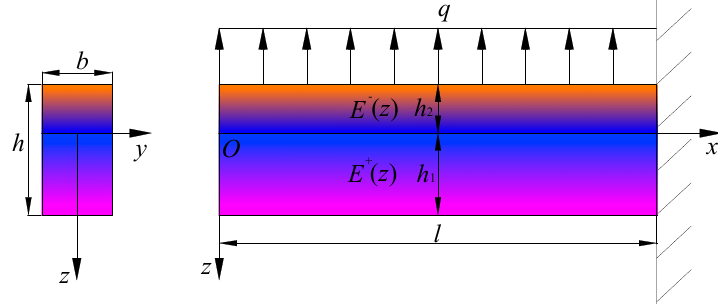
Figure 3. Scheme of a bimodular FGPM cantilever beam under uniformly-distributed load.